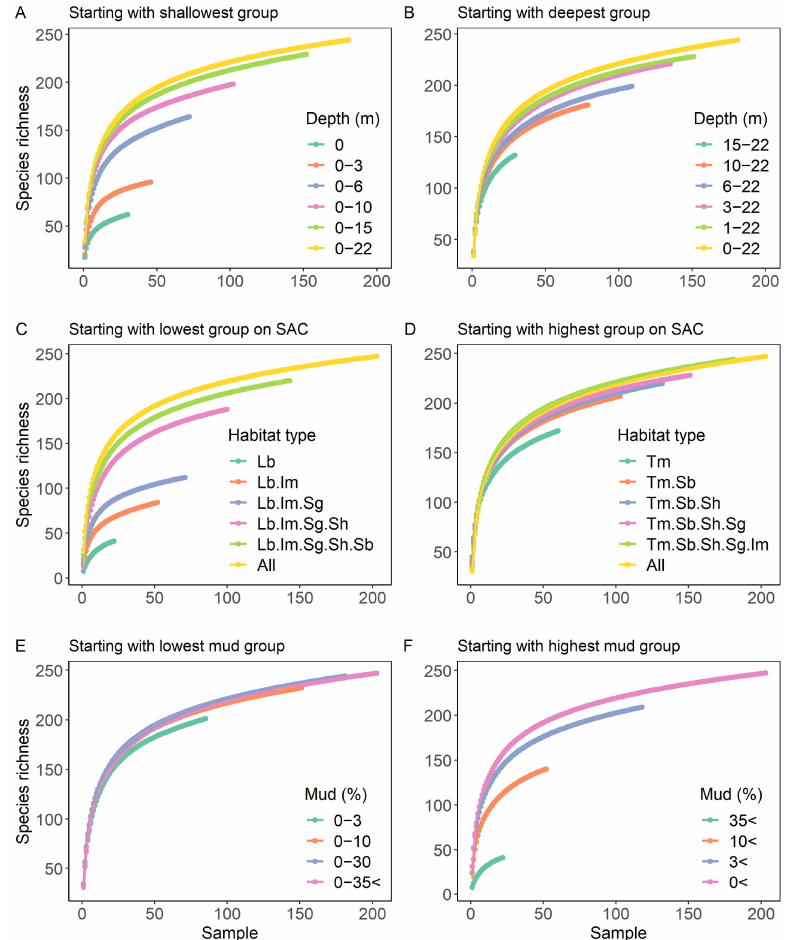
Figure 5. Additive species accumulation curves grouped by water column depth ( A , B ), habitat type ( C , D ), and sediment mud content ( E , F ). Lb = large burrows; Im = infaunal molluscs; Sg = seagrass; Sh = shelly; Sb = small burrows and Tm = tube